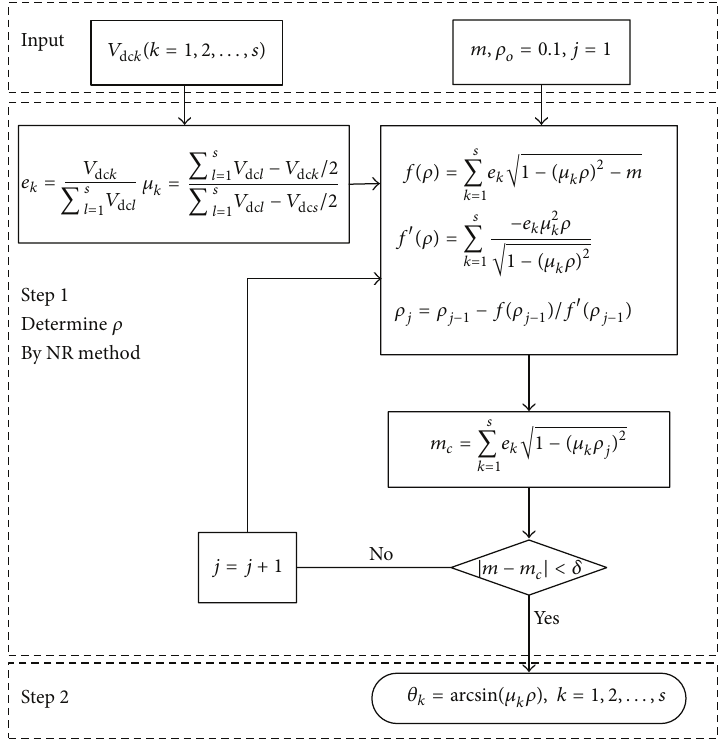
Figure 6: Flow chart of calculation in Yu’s paper.